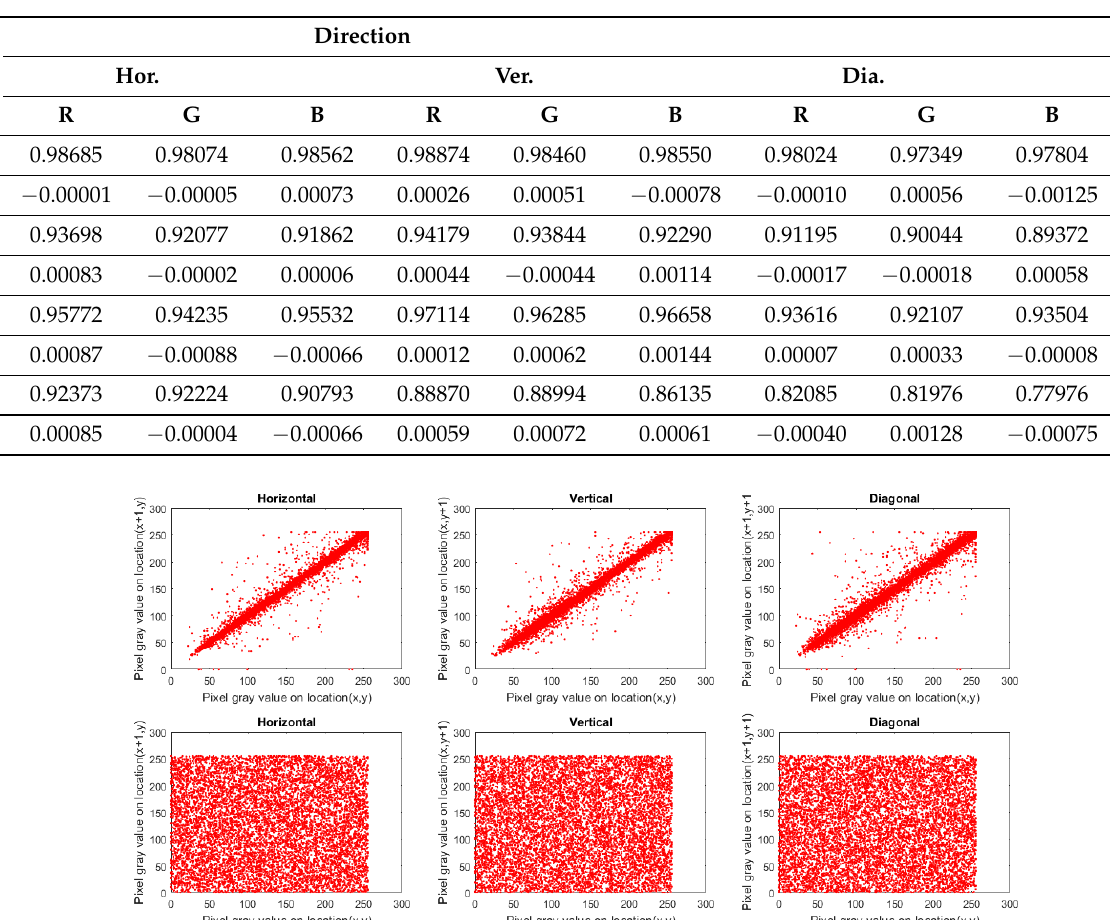
Table 3. Correlation coefficient of neighboring pixels for the experimented images.